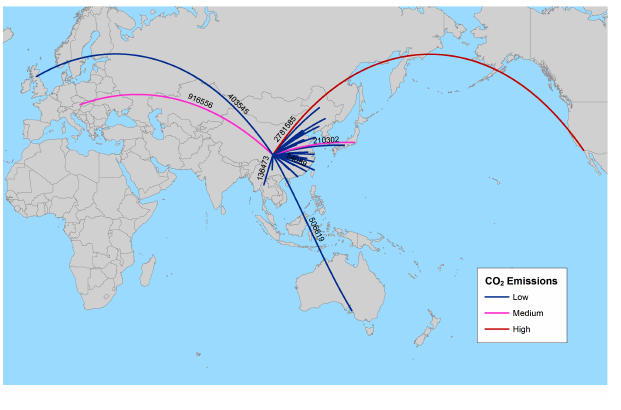
Fig. 8 . Environmental effects associated with the transportation Fig. 9 . Economic effects associated with panda loans across the of pandas across the globe in terms of CO emissions. Values telecoupled system. Values represent returns of investment 2 are expressed in kilograms, assuming an amount roughly equal (revenues – costs). Negative returns (losses) are shown in red, to 29 kg/km emitted by Boeing 777 jets. Total CO emissions small positive returns (profits) in yellow, and large profits in 2 were calculated based on the number of pandas transferred and green. A lack of data on indirect revenues from tourism in both on the assumption that each airplane can carry a single unit per the sending and receiving systems caused the receiving systems trip. Lower emissions are shown in blue, medium emissions in to show only losses from panda loans. At the same time, costs magenta, and high emissions in red. involved in production of bamboo in Holland were not considered, and thus show only